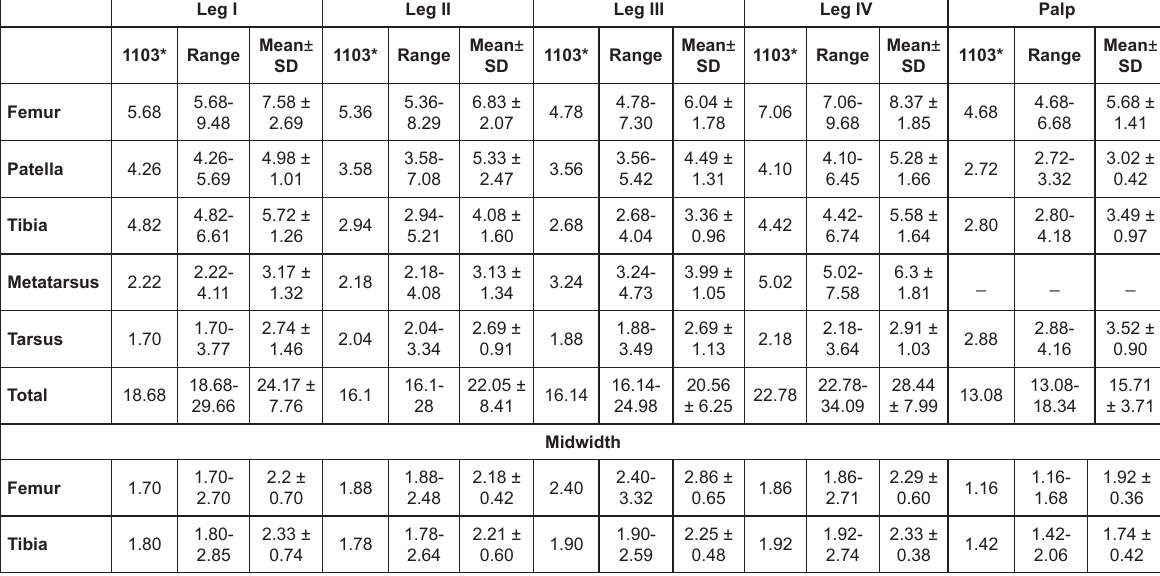
1103* - Specimen from Matheran